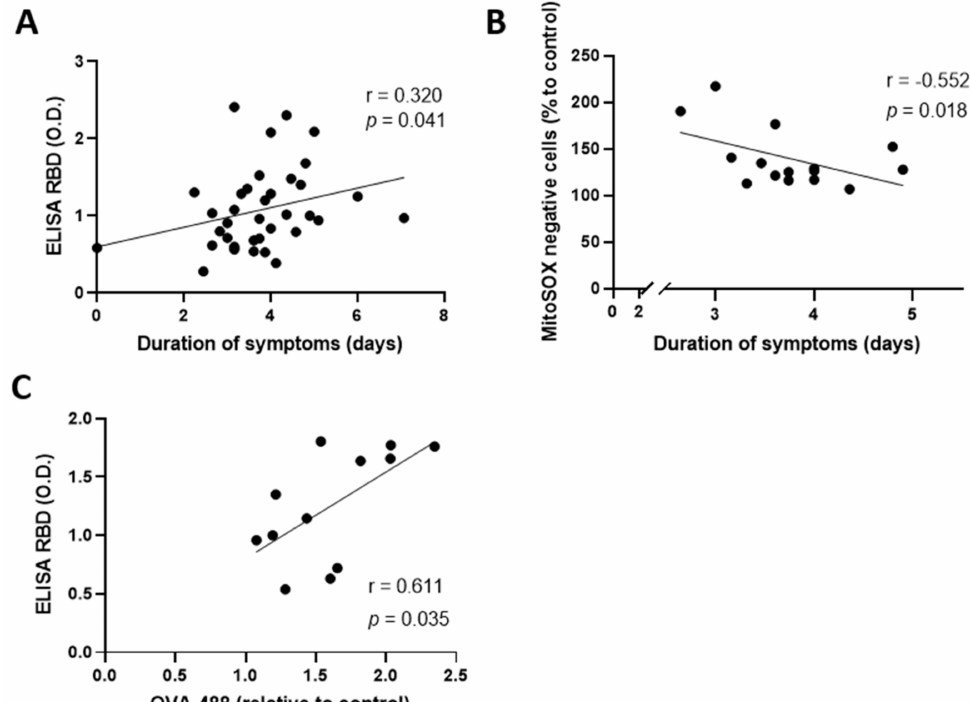
Figure 1. Elevated antibody concentrations and prolonged symptoms are detrimental for the lym- phatic endothelium integrity. ( A ) Correlation between the duration of symptoms (square-root transformation) and the concentration of plasmatic SARS-CoV-2- receptor-binding-domain anti- bodies measured by ELISA. ( B ) Correlation between the duration of symptoms and MitoSOX TM Red-negative cells measured by flow cytometry after incubating aHDLEC with convalescent plasma for 4 h and cytokines cocktail for 20 h. ( C ) Correlation between the concentration of plasmatic RBD antibodies measured by ELISA and the permeability of the endothelium measured by spec- trophotometry (absorbance of OVA-488) after incubating human LEC with convalescent plasma for 4 h and cytokines cocktail for 20 h. Each point represents a treatment. Significance ( p < 0.05) was determined by a Pearson correlation. A square-root transformation of the duration of symptoms to reach normal distribution was performed. RBD—receptor-binding domain; O.D—optical density; OVA—ovalbumin; aHDLEC—adult human dermal lymphatic endothelial